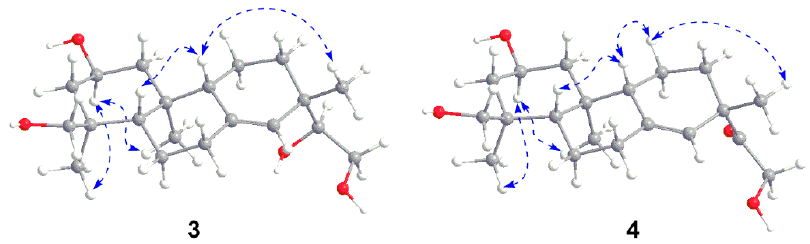
Figure 5. Key NOESY correlations of compounds 3 and 4 . Table 2. 1 H- and 13 C-NMR data (500 and 125 MHz, resp. δ in ppm) of compounds 3 and 4 .